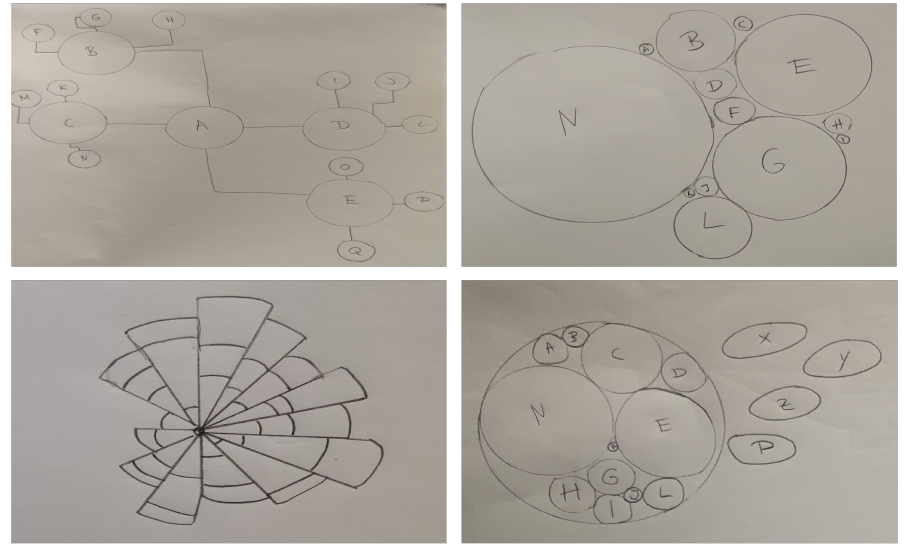
Figure 5. Develop: Visualizing new potential